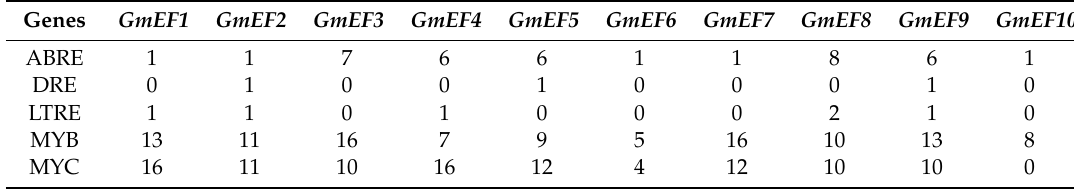
Table 2. Distribution and numbers of cis -acting elements in soybean EF1 α genes.